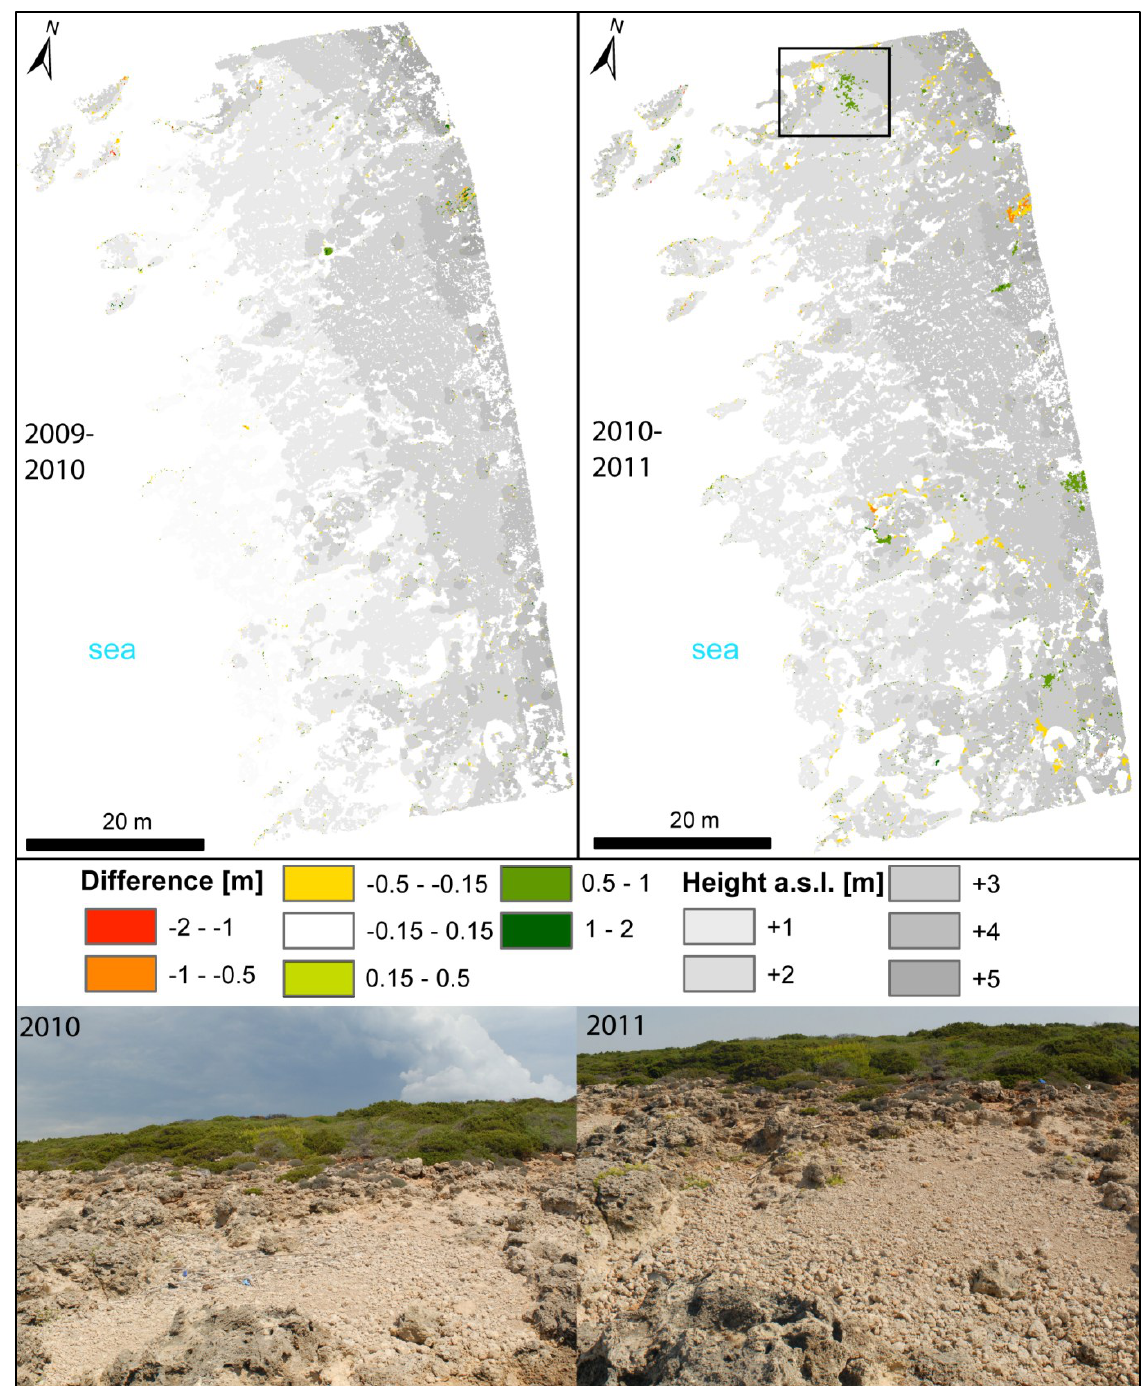
Figure 4. Two annual comparisons of the area of Katakolo, Peleponnes Peninsula. According pictures of a selected area (white box) are shown below. Gravel was reordered in this time